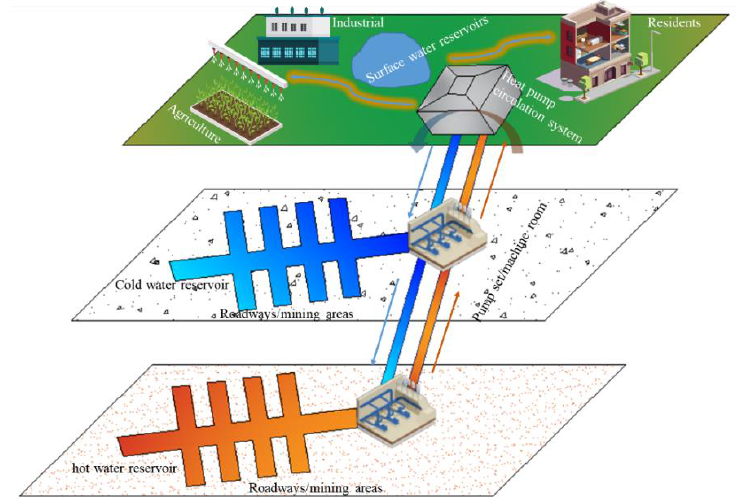
Figure 4. Geothermal energy utilization model of abandoned mines.